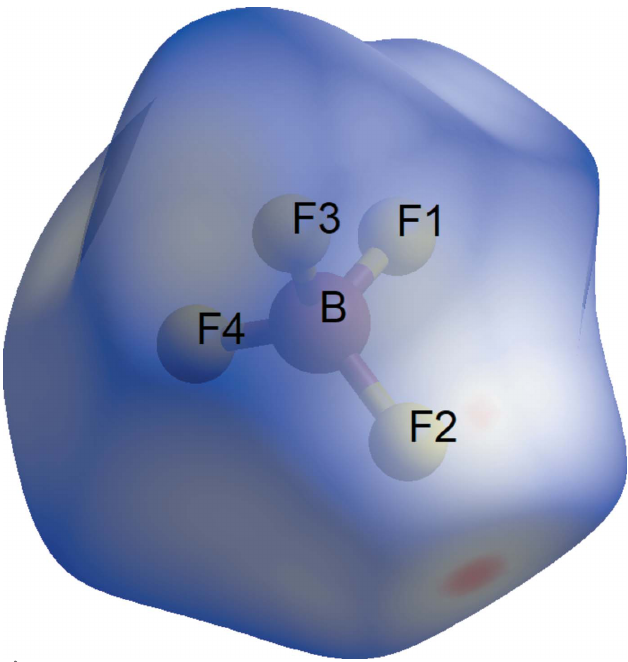
Fig. 3. The hydrogen bonds listed join cations and anions into thick wavy (010) sheets, as can be seen in Fig. 2 b .